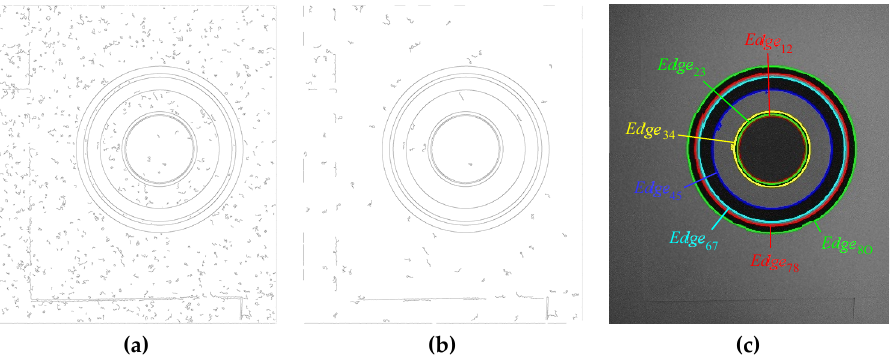
Figure 12. Edge detection and layering of I 2 with mixed noise. ( a ) Candidate edges by Canny detection; ( b ) Structural edges by filtering based on length and linearity; ( c ) Layering result of I 2 , in which edges in di ff erent layers are rendered with di ff erent colors.